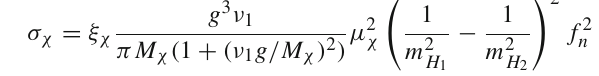
parameter and depends on three independent parameters of may be very small and our model, M s , g and M χ . Also m H 2 so the contribution of its propagator to the direct detection cross section can be very large. For this reason, a large portion of parameter space is excluded by this observable. In order to show the allowed region in parameter space, we display scatterpointsinFig.6.Figure6a–cdepicttheallowedregions in g , λ φ s and M s forscalarDMandFig.6ddepictstheallowed regions in g and M χ for fermionic DM, which are consistent with experimental measurements of σ Xenon100 and σ LUX .